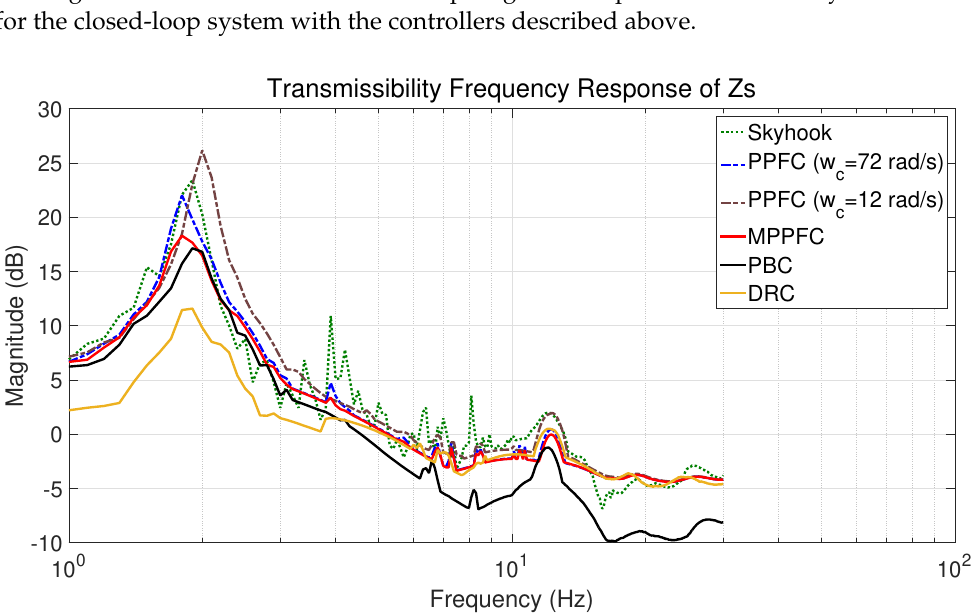
Figure 8. Comparison of TFR of the sprung mass displacement for different damping control.